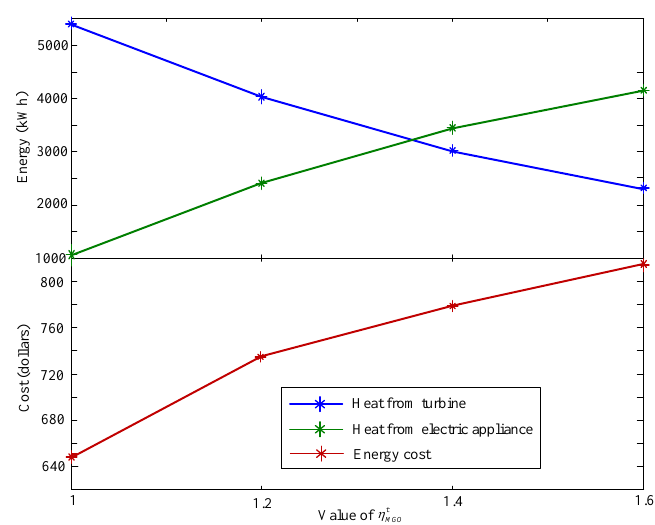
Figure 7. Thermal demand and cost for different values of profit coefficient.